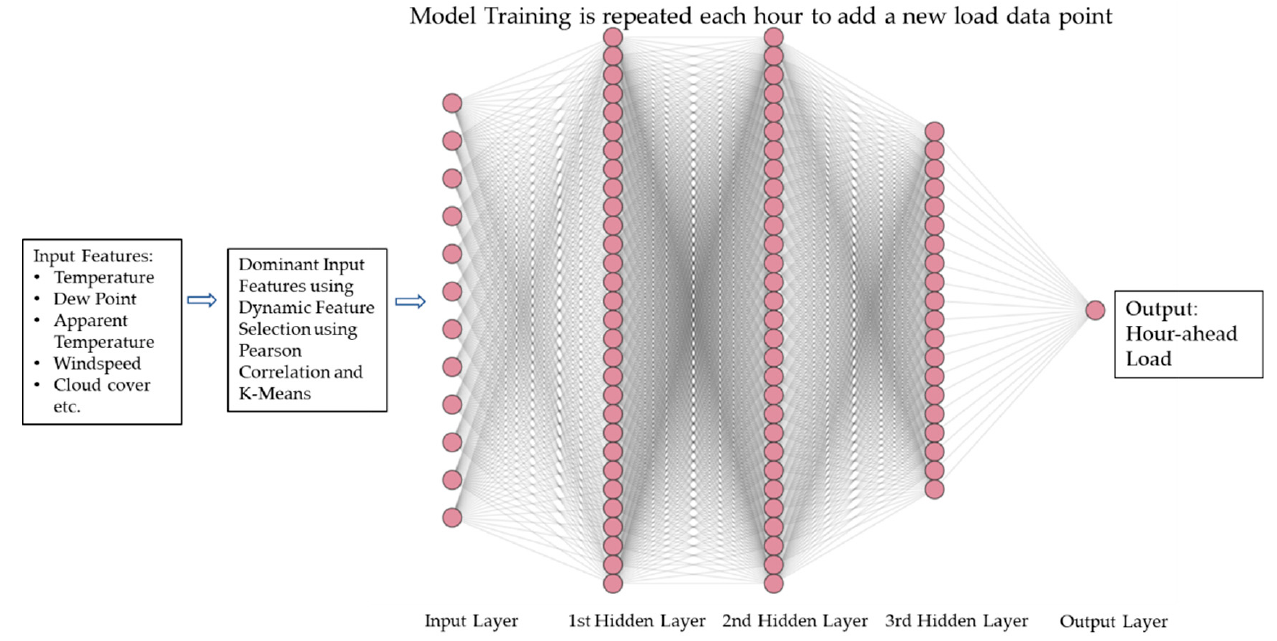
Figure 4. ANN network [52].